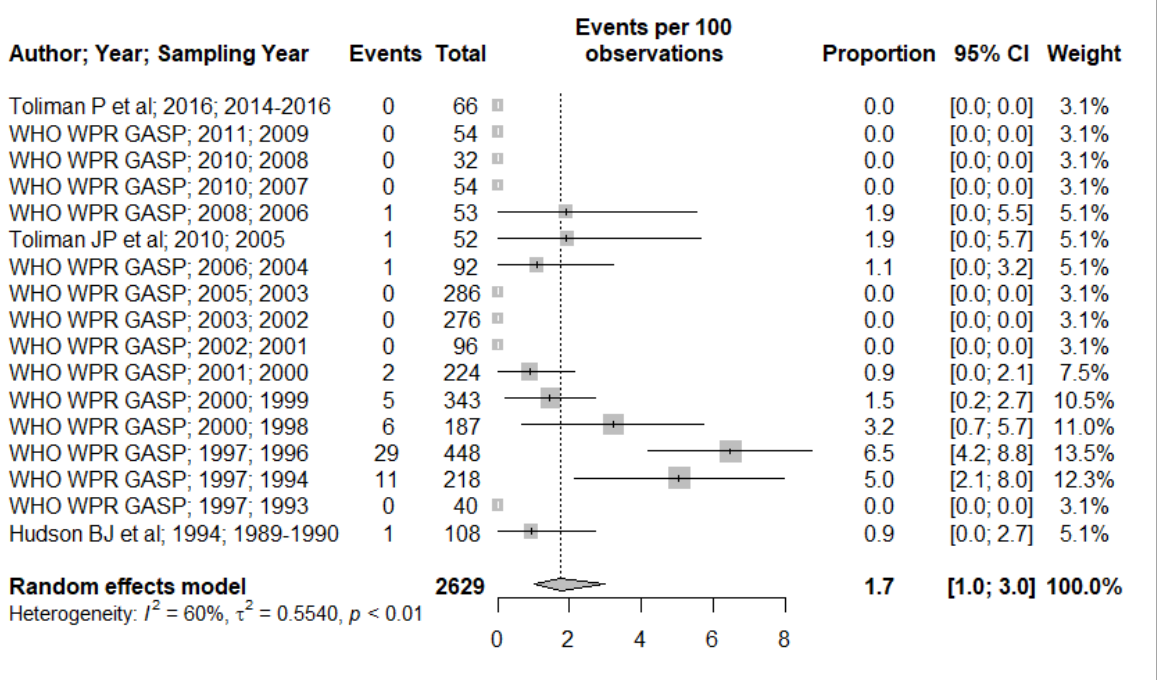
Figure 6. Spectinomycin resistance prevalence estimate.